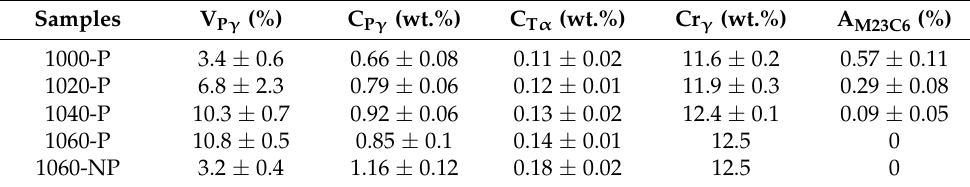
Table 1. Volume fraction of RA, elements (C, Cr) content and the area fraction of M 23 C 6.